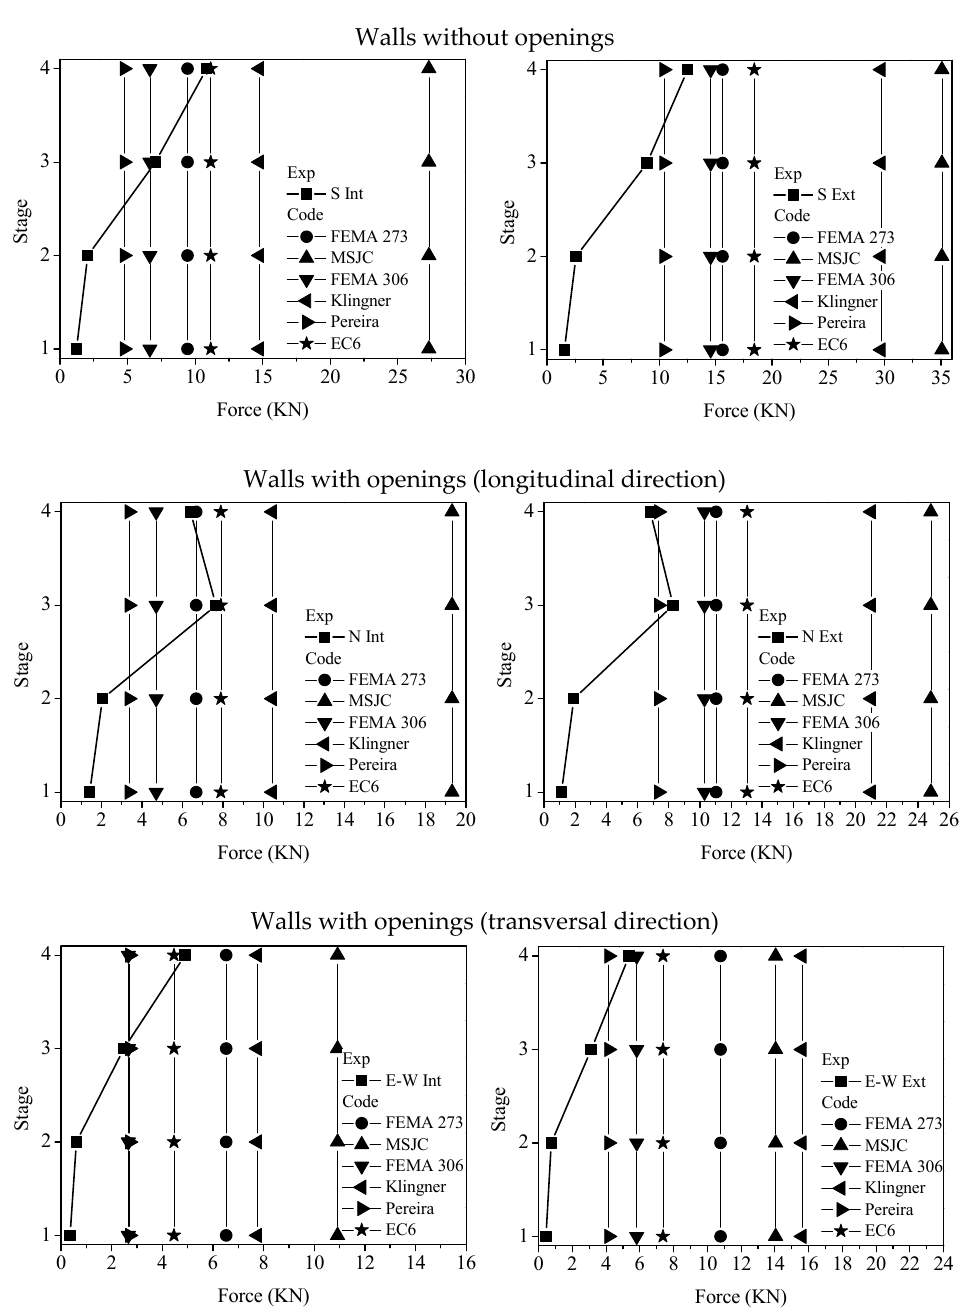
Figure 13. Standard and experimental out-of-plane capacity comparison for model 1. It should be noted that the maximum out-of-plane load recorded on the longitudinal walls with openings was higher than the load recorded for the solid infill walls of the same direction and, particularly in model 2, the ground floor infill walls with openings were on the verge of collapsing, while the solid walls had less damage. This might lead to the as- sumption that the recorded values for the longitudinal infill walls with openings were in fact the maximum capacity, while the solid walls could endure a higher out-of-plane load, hence the underestimation by most analytical solutions. Other aspects that might contrib- ute to these discrepancies are the in-plane damage and the possible effect of the restraint of boundary conditions and arch effect, due to the slenderness and openings.